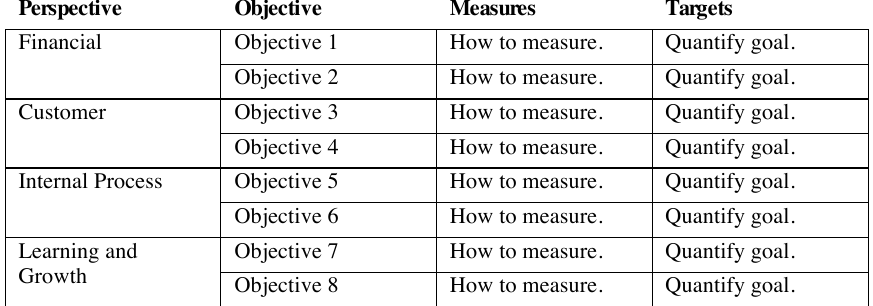
Table 1. Balanced